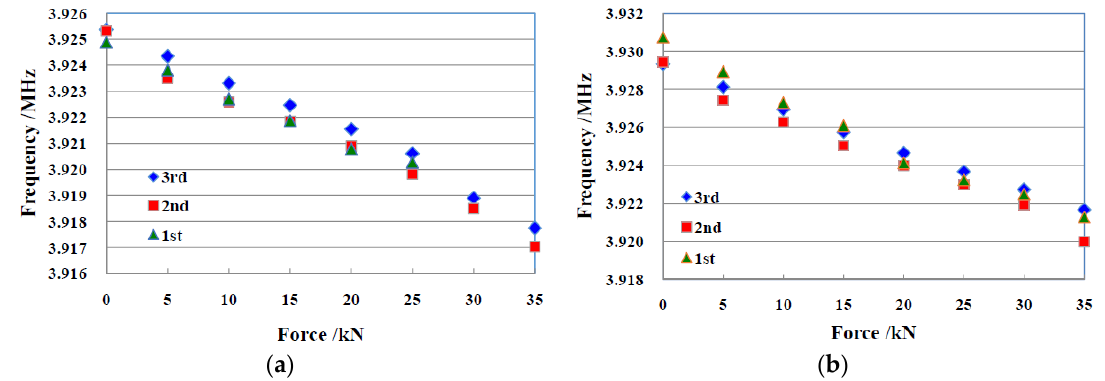
Figure 7. Frequency change for M16bolt with maximum 35 kN bolt preload. ( a ) Real part; ( b ) Imaginary part.